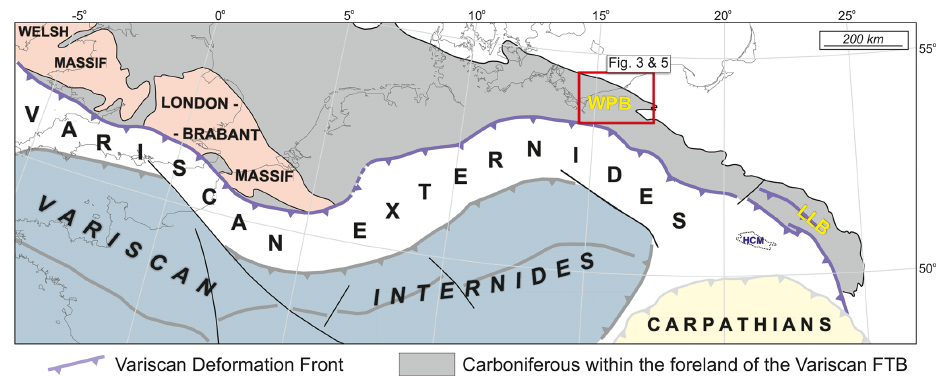
Figure 2. Regional map showing main elements of the Variscan orogenic belt and its foreland between the UK/France and Poland/Ukraine (adopted from Krzywiec and Kufrasa, submitted, compiled after Mazur et al., 2020; Narkiewicz, 2007, 2020; Opluštil and Cleal, 2007; Ziegler, 1990; Martínez Catalan et al., 2020). Grey area: present-day post-erosional extent of the Carboniferous basin. WPB: western Pomera- nian Basin, LLB: Lublin–Lviv Basin. Variscan orogenic front (thick dark violet line) is shown as a foreland-verging thrust but it should be kept in mind that this is regional generalisation meant to illustrate general vergence of the entire thrust belt and that along that front also backthrusting and wedging could be observed. HCM: Holy Cross Mountains.